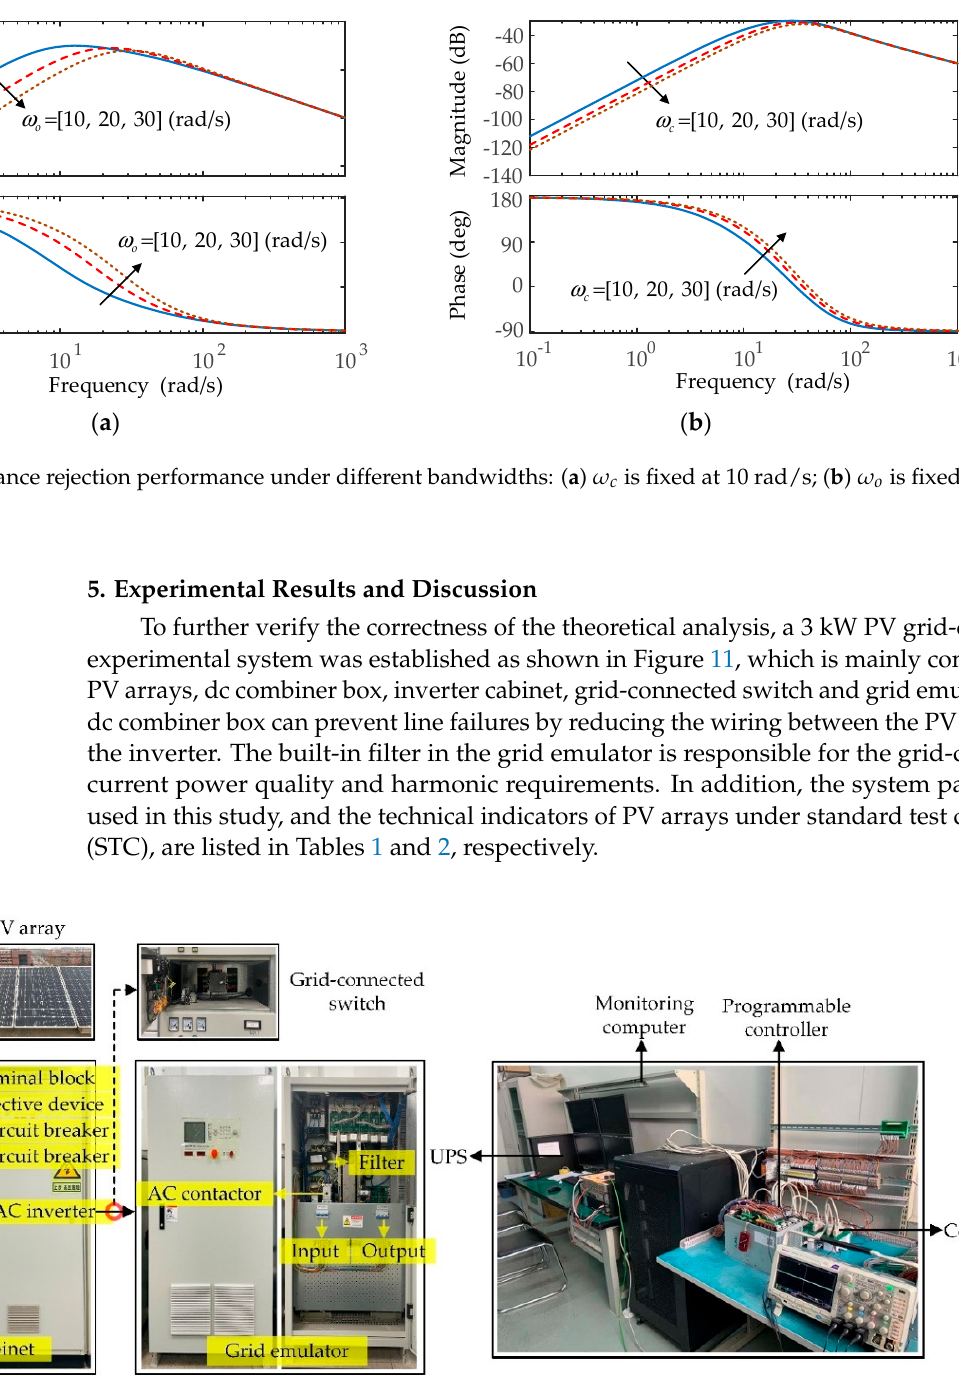
Figure 9. Comparison of disturbance rejection performance between conventional LADRC and modified one.